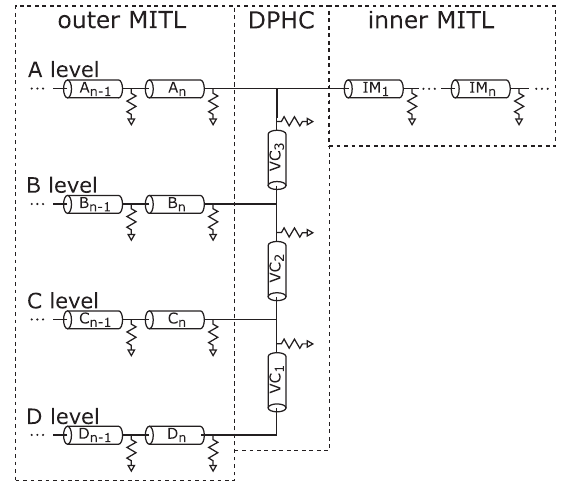
FIG. 12. Circuit diagram of the outer MITL, vacuum convolute, and inner MITL. Each transmission line element has an asso- ciated resistor to ground that is adjusted to account for current loss at each element. The electron flow current is calculated for each of the four outer MITL levels. The electron flow current that has propagated to the end of the outer MITLs is then distributed throughout the vacuum convolute (DPHC) and inner MITL